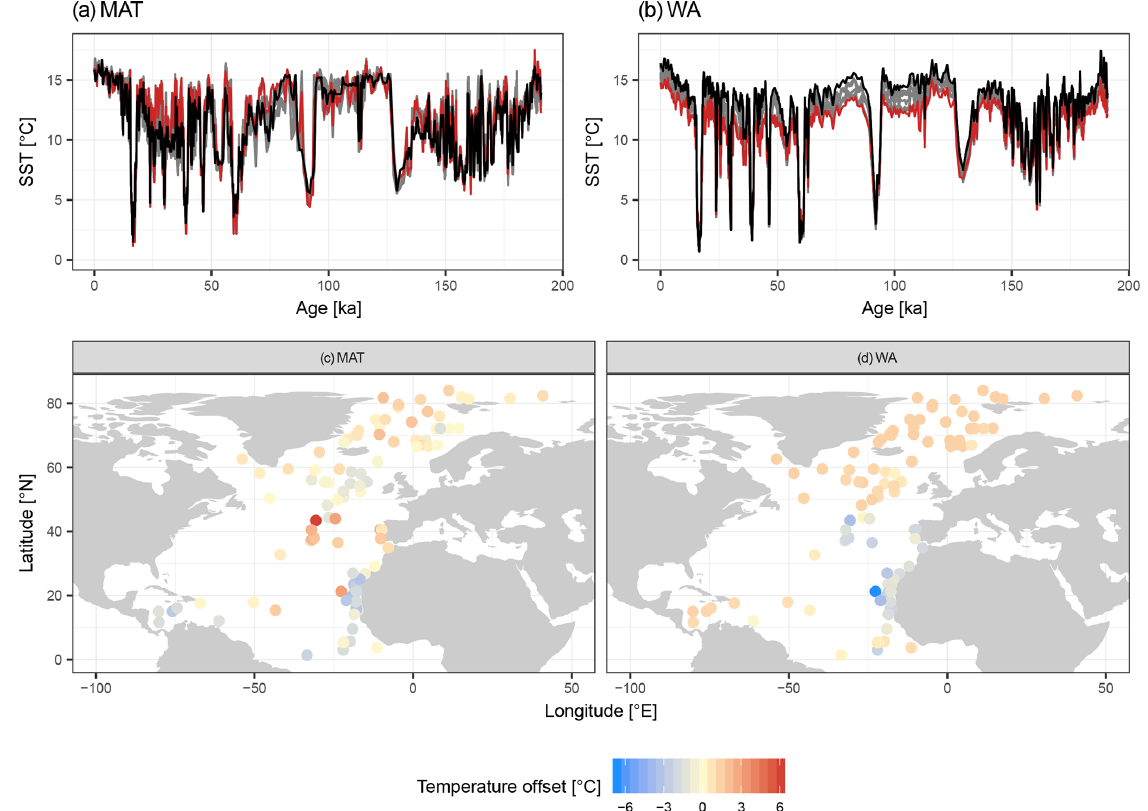
Figure 4. Species selection affects SST reconstructions: examples from two independent datasets showing the effect on temporal and spatial patterns in reconstructed SST. (a, b) SST reconstructions for core MD95-2040 from the Iberian Margin using 33 possible transfer function models with the number of species increasing according to their ranking. Red lines show the reconstructions with essential species only, dark grey lines the reconstructions with more species, and the black line is the “final” reconstruction with all species. (c, d) Spatial pattern of the difference between the SST reconstruction for the LGM with the minimum and with all species